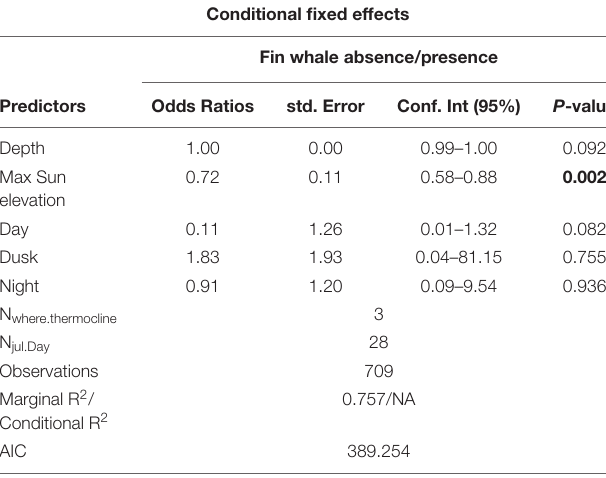
TABLE 3 | Model output for fin whales.